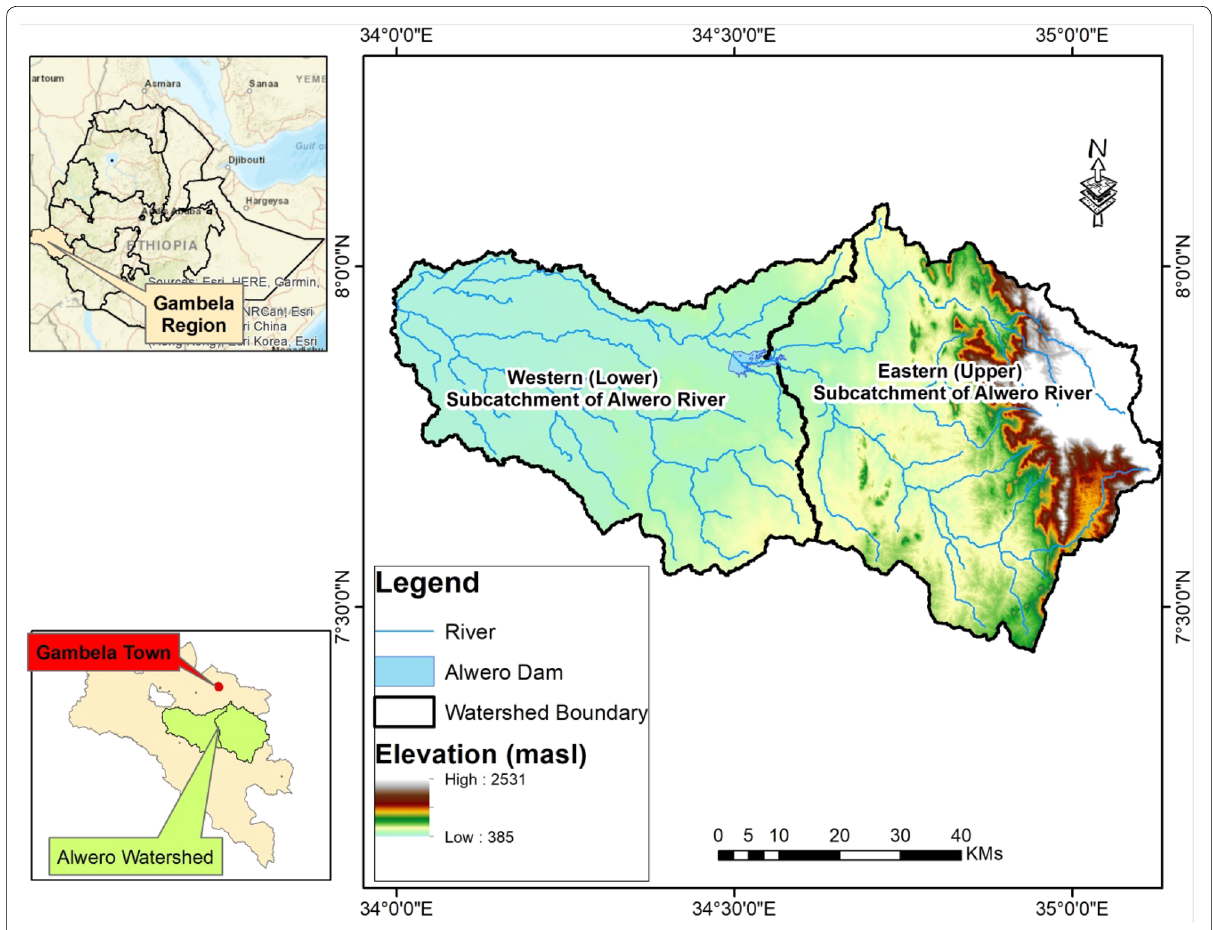
Fig. 1 Location of the study